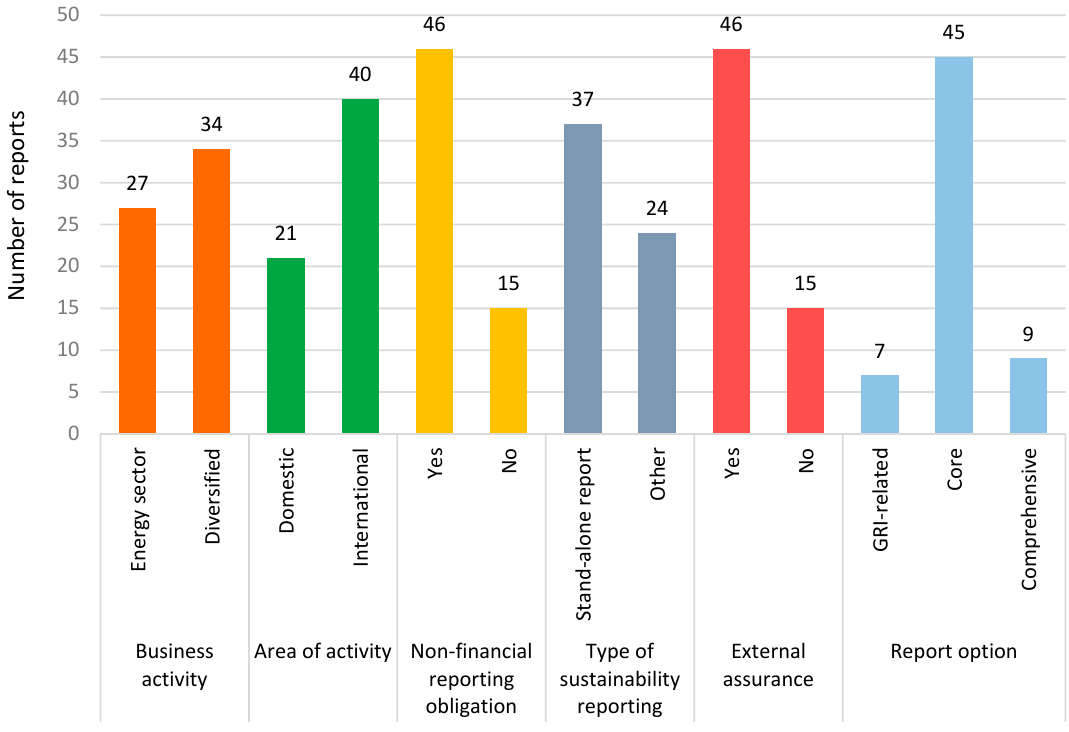
Figure 3. Characteristic of research sample.